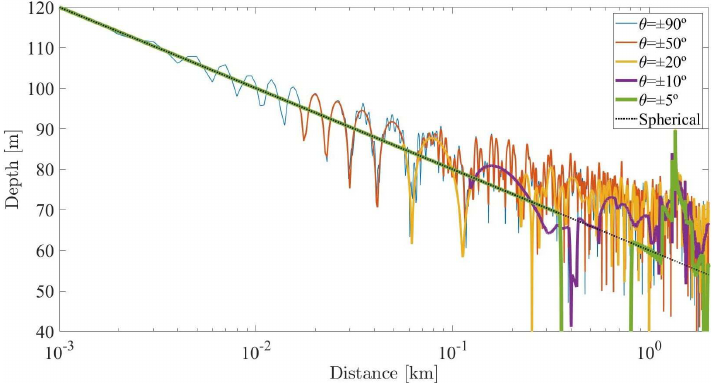
Figure 11. Sound pressure levels along a direction at the same depth of the acoustic source, considering different